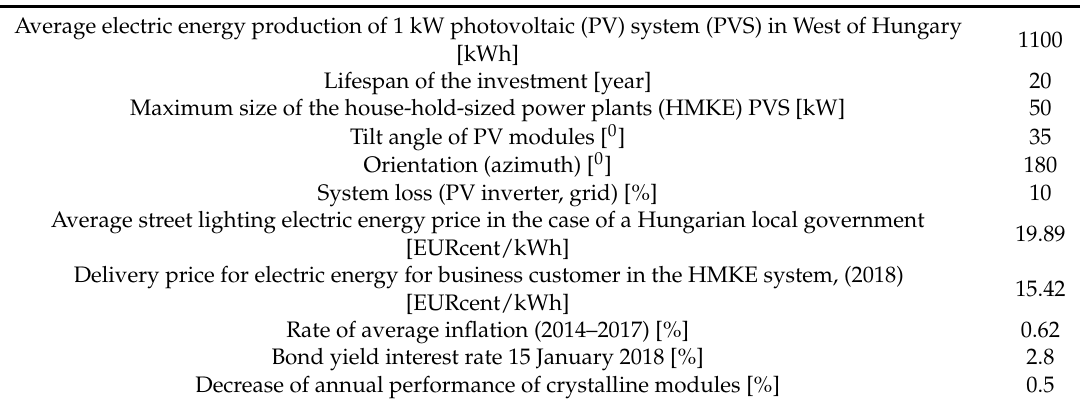
Table 2. Initial data for calculations